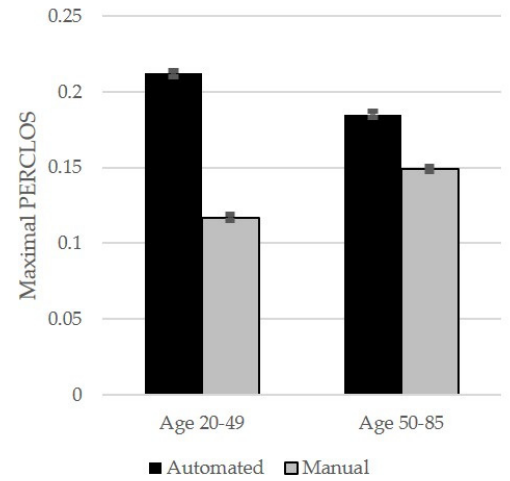
Figure 5. Driving automation had different effects in various age groups. Error bars indicate SD.